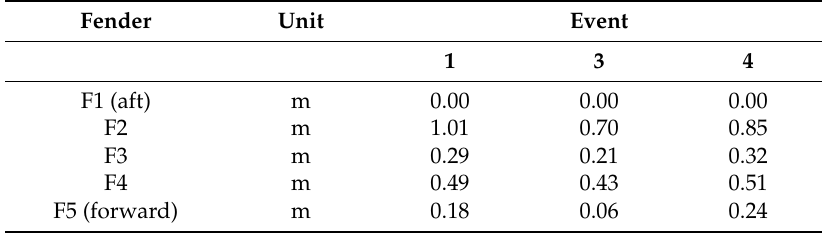
Table 6. Maximum fender compressions for the Base Case.